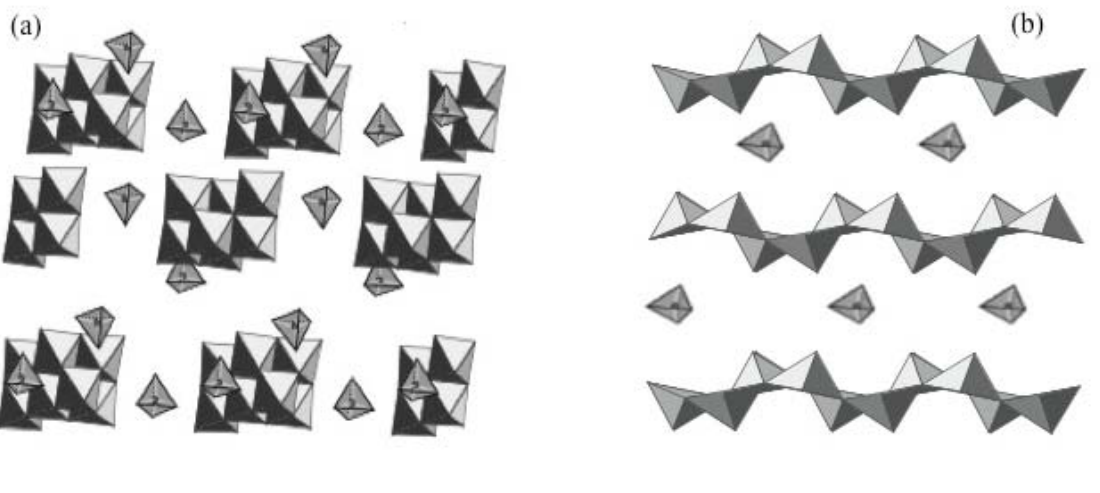
Figure 4. Structure of (a) (TMA) TMA[V O ] obtained under hydrothermal 4 10